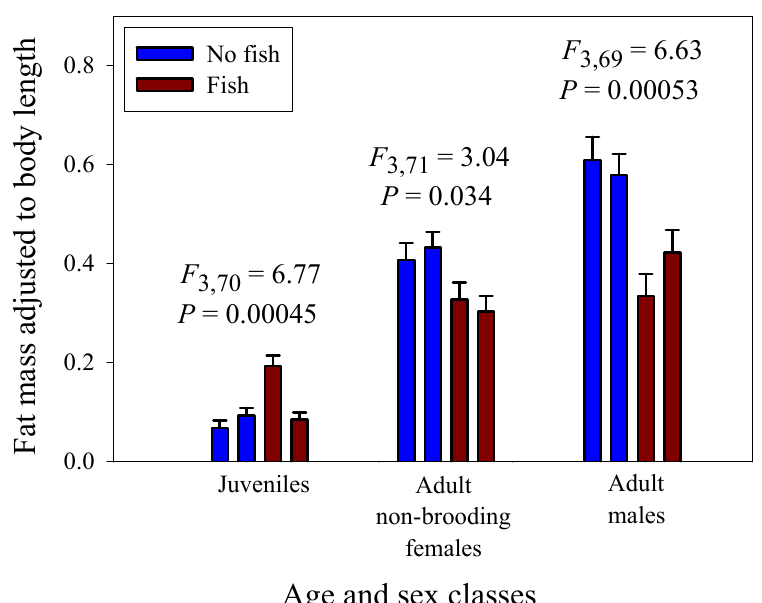
Figure 5. Mean fat mass ( ± 95% confidence intervals) adjusted to body length by ANCOVA in juveniles, adult non-brooding females and adult males from four populations of the amphipod Gammarus minus , two from springs with fish (red bars) and two from springs without fish (blue bars). Shown are F and P values from the ANCOVA analyses for each size and sex class.